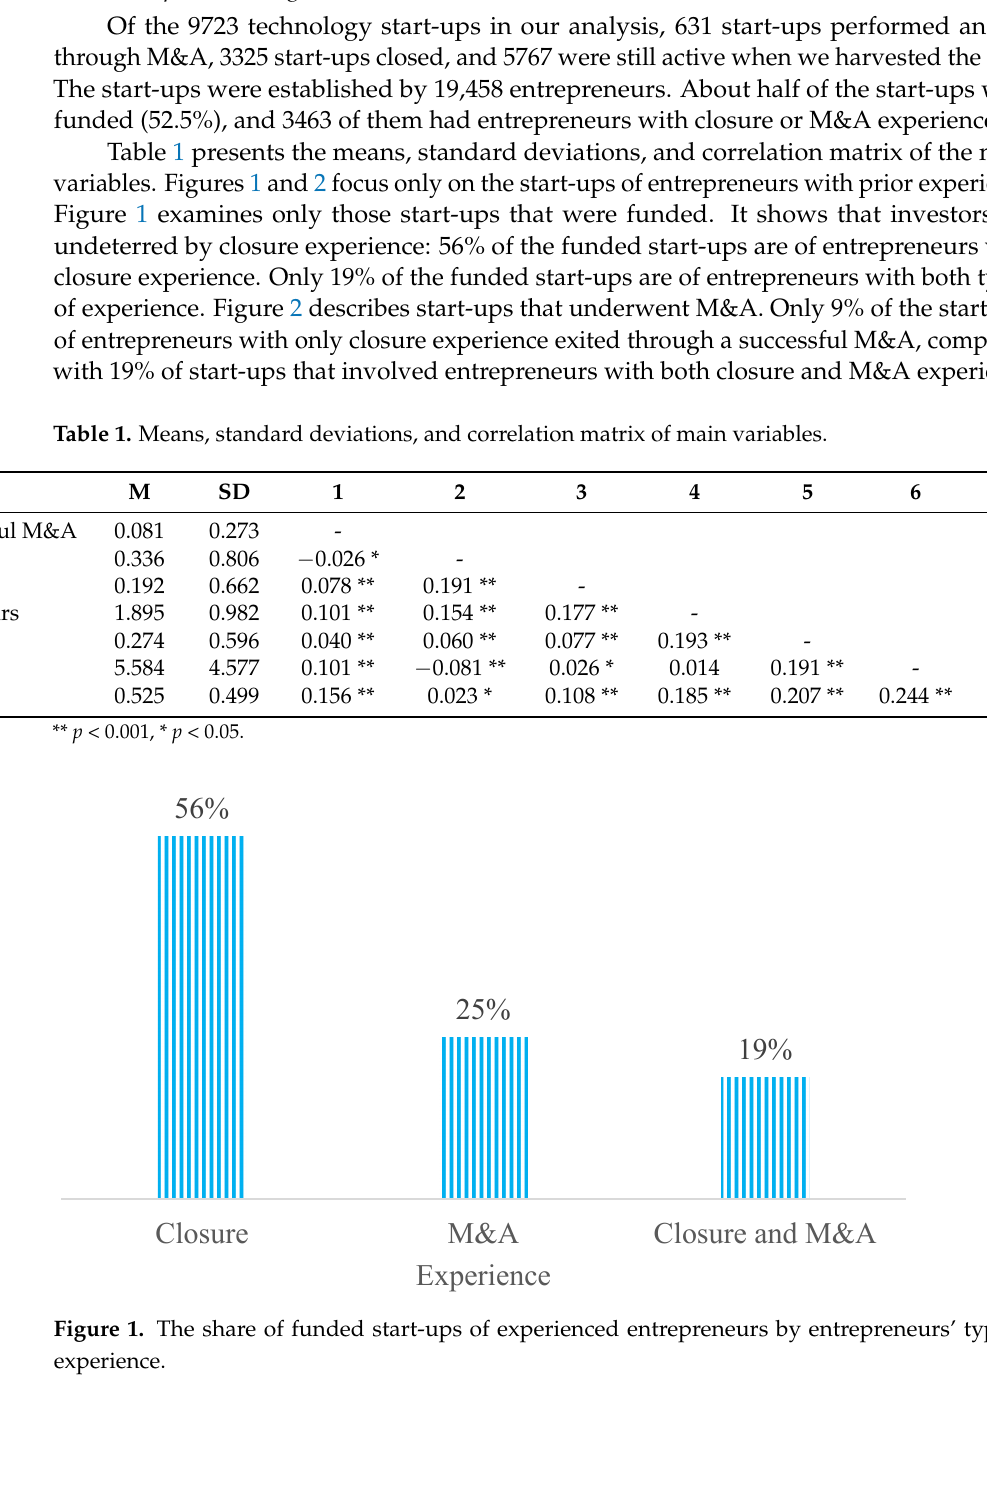
Figure 2. The share of types of experience among start-ups that underwent M&A. 4.2. Hypotheses Testing H1 posits that entrepreneurs with closure experience are negatively associated with the probability of M&A. Model 1 (Table 2) shows the logit model estimation testing the association between entrepreneurs’ closure and M&A experience and the probability of M&A. We find that closure experience is negatively associated with performing M&A ( β = − 0.139, p < 0.05), in support of H1. As expected, M&A experience is positively associated with performing M&A ( β = 0.178, p < 0.001). H2 posits that entrepreneurs with closure experience are positively associated with the probability of M&A when co-founding with entrepreneurs with M&A experience. Model 2 (Table 2) includes the interaction between closure experience and M&A experi- ence. Closure experience is negatively associated with performing M&A ( β = − 0.227, p < 0.001), but the interaction is positively associated with performing M&A ( β = 0.097, p < 0.001). Because the logit model is not linear, it is challenging to interpret the interaction effects. Thus, we follow Gruber et al. (2013) and offer a graphical analysis of this interac- tion, based on a prediction of the interaction values wherein we keep the other variables